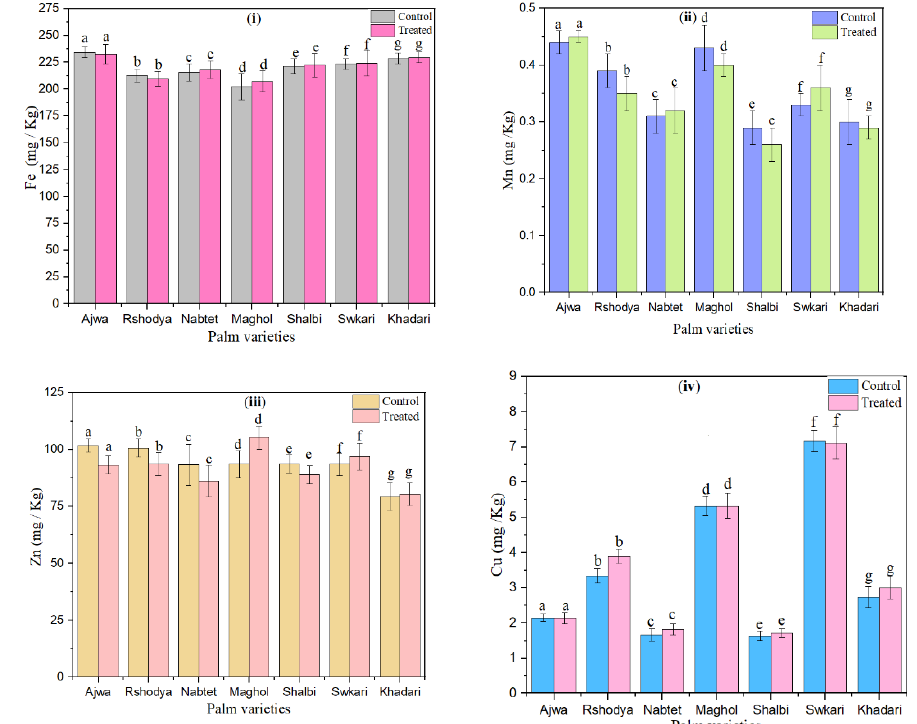
Figure 5. The effect of SDBD plasma on microelements (mg/Kg) of palm dates, ( i ) Fe, p value = 0.23, ( ii ) Mn, p value = 0.99, ( iii ) Zn, p value = 0.18, and ( iv ) Cu, p value = 0.07, lowercase letters a–g in the same column represent significance analysis; the different letters mean significant difference among various treatments at p < 0.05 level.